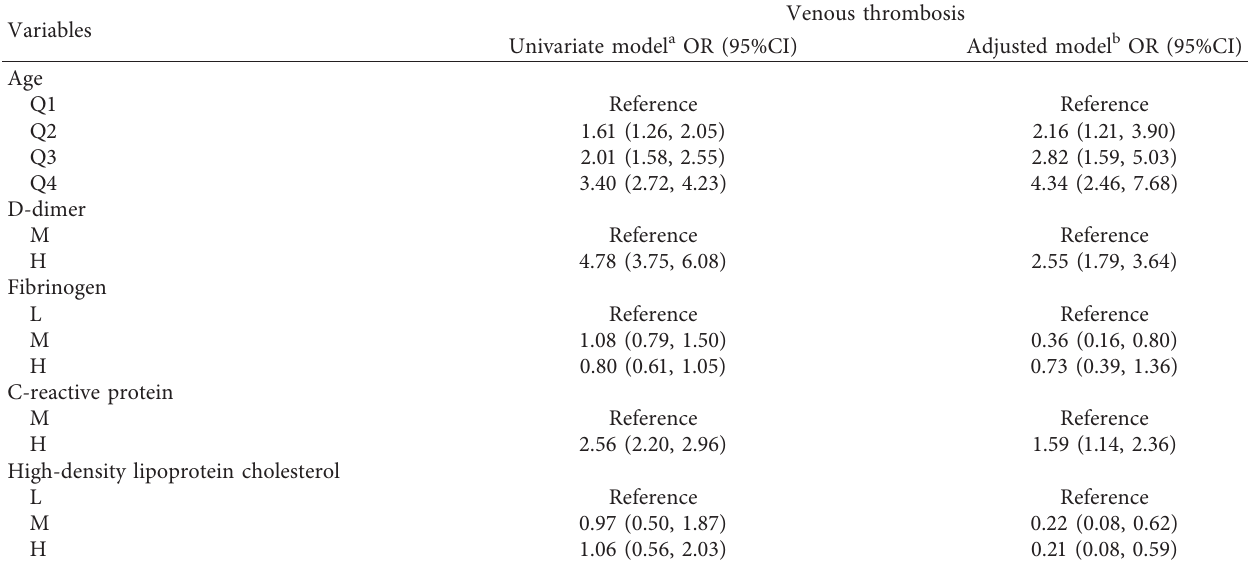
Table 2: Results of univariate and multiple logistic regression models of the predictive risk factor of VTE in fracture patients.